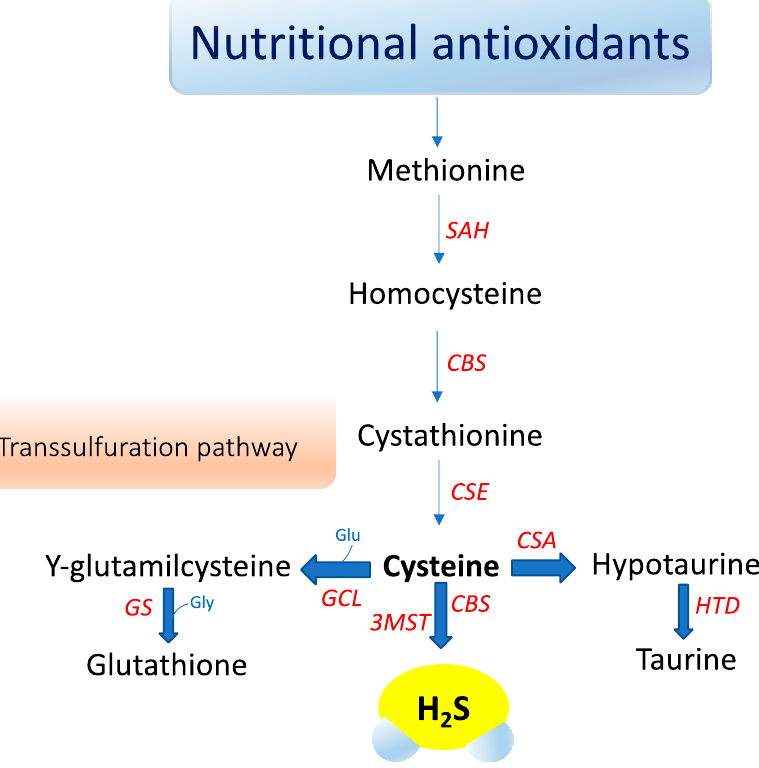
Figure 1. Nutraceutical support of intracellular H 2 S synthesis via cysteine metabolism. S-adenosyl homocysteine hydrolase (SAH), Cystathionine- β -synthase (CBS), 3-mercaptopyruvate sulfurtransferase (3-MST), Cystathionine gamma lyase (CSE), Cysteine sulfinate (CSA), Hypotaurine dehydrogenase (HTD), Glutamate cysteine ligase (GCL), Glutathione synthetase (GS), Glycine (Gly).